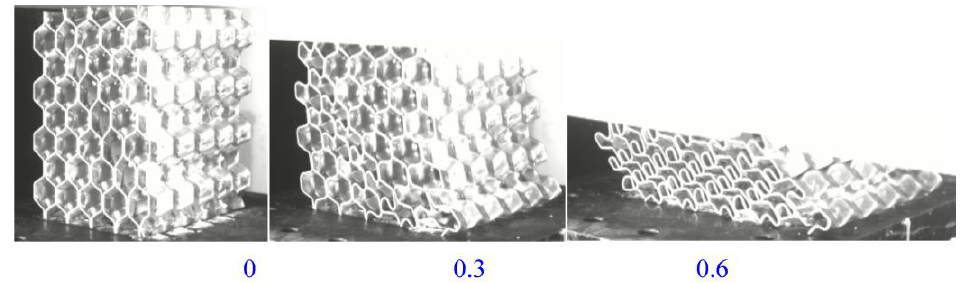
Figure 14. Dynamic test process in the radial direction.